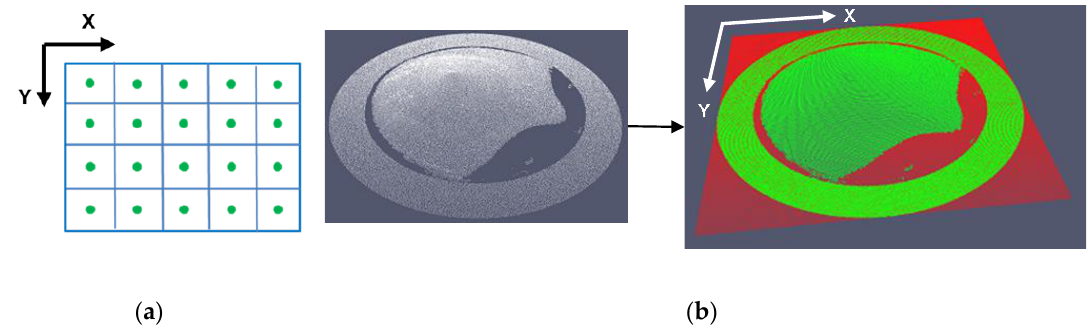
Figure 20. Procedure to generate a rectangular grid from a point cloud by preserving the holes: ( a ) the rectangular grid configuration; ( b ) example of rectangular grid generation by preserving the holes (red point sections) from the stretched point cloud corresponding to Patient 002.